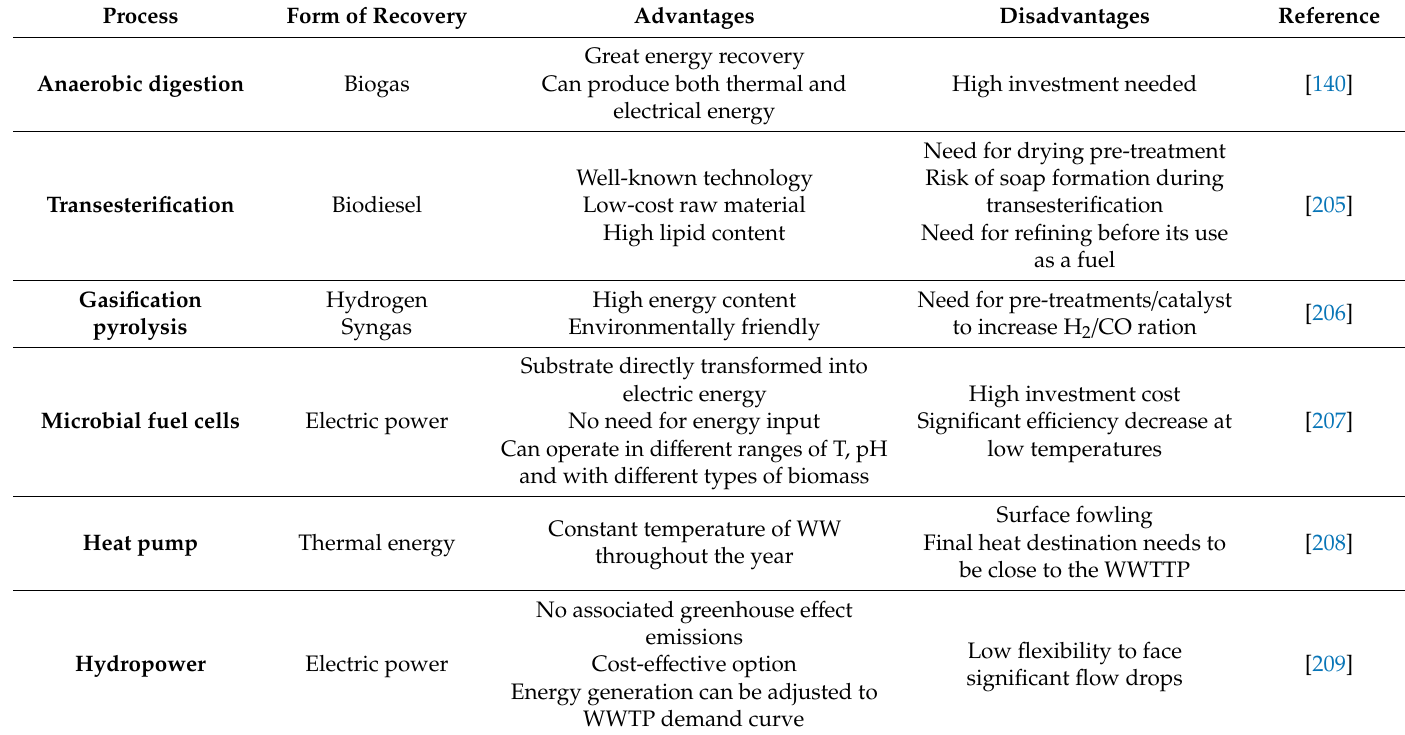
Table 11. Technologies used for energy recovery from